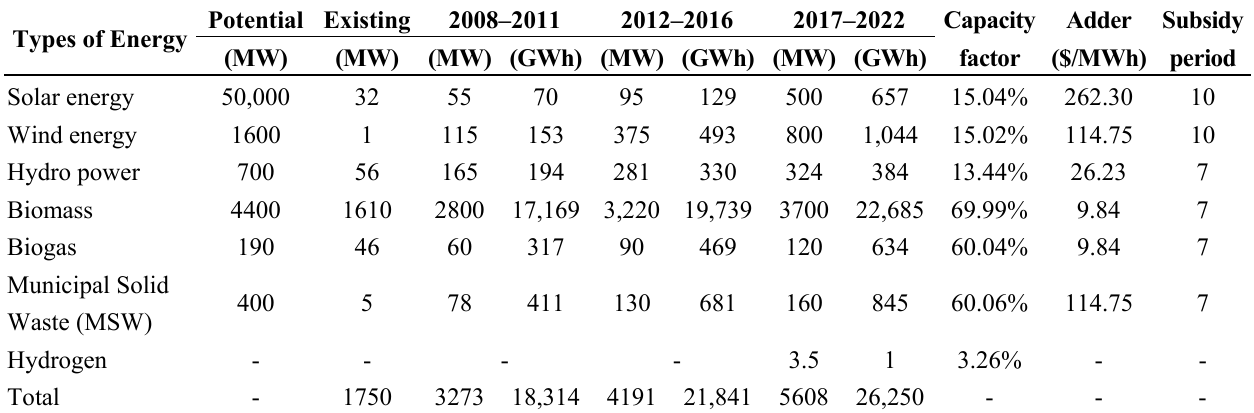
Table 3. Potentials, targets and adders for renewable power in the AEDP